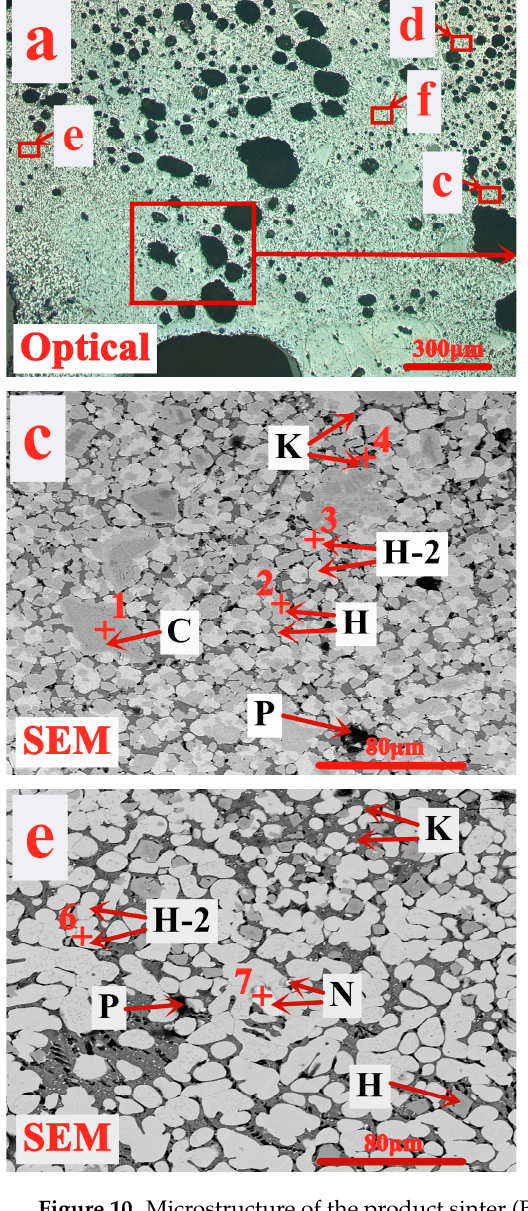
Figure 10. Microstructure of the product sinter (B) of the pressurized densification sintering process (H—(Fe, Mg)(Fe, Al) 2 O 4 , H-1—Fe(Fe, Al) 2 O 4 , H-2—(Fe, Mg)Fe 2 O 4 , K—CaO · (Fe, Mg)Al 2 O 4 · SiO 2 , SFCA—silico-ferrite of calcium and alumina, N—NiFe 2 O 4 , C—(Fe, Mg)(Cr, Fe, Al) 2 O 4 , P—Pore). ( b – f ) are the selected areas in ( a ). Table 5. EDS analysis results for the areas in Figure 10.